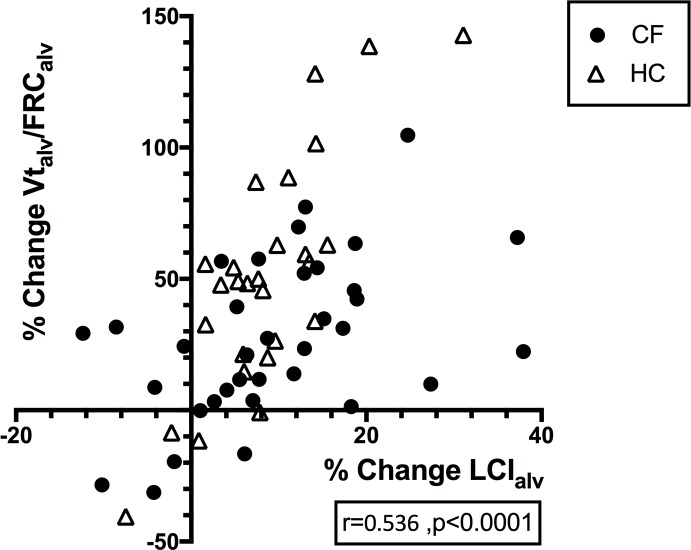
Scatter plot with Spearman correlation of the % change in the ‘alveolar’ Vtalv/FRCalv with the % change in ‘alveolar’ LCIalv for both cystic fibrosis (CF) and healthy control (HC) subjects combined.The Spearman correlation suggests a positive relationship between increasing % change Vtalv/FRCalv and increasing % change LCIalv.